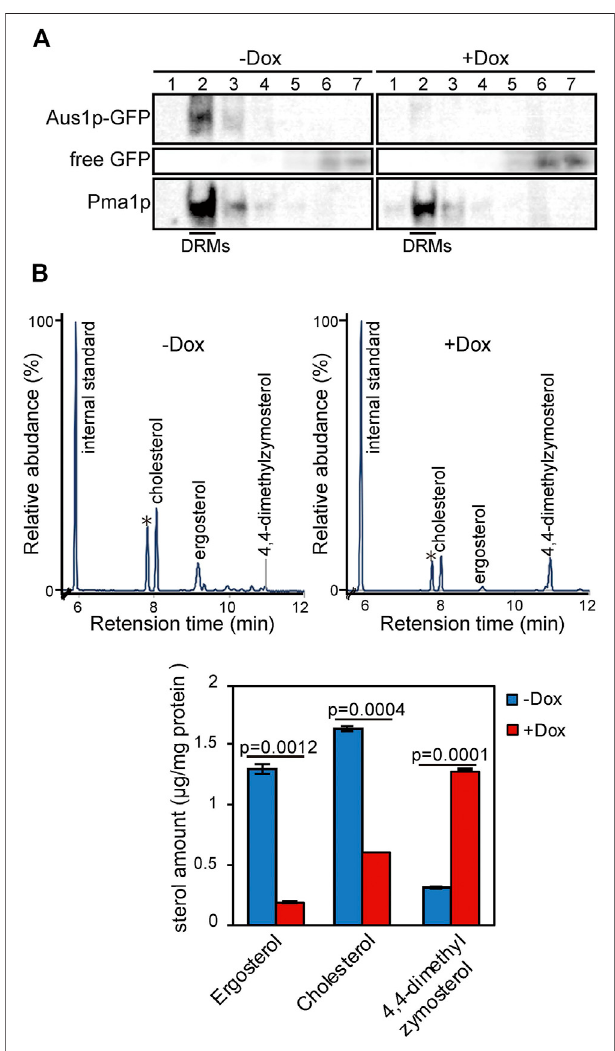
FIGURE 3 | ERG25 knockdown causes the dissociation of Aus1p from detergent-resistant membranes (DRMs) and a component change of